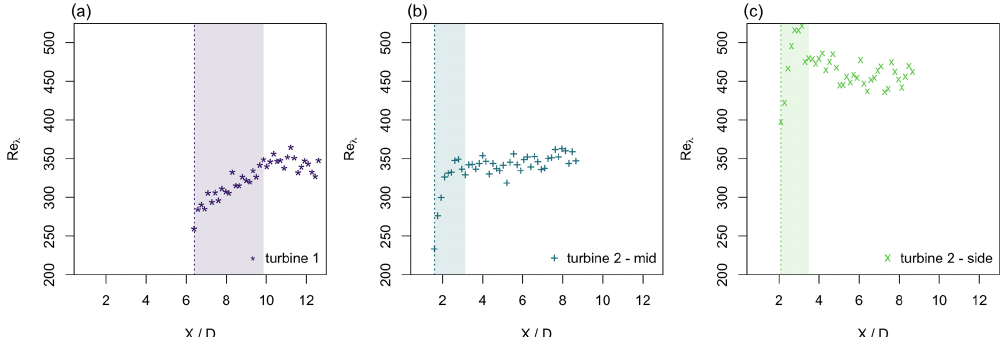
Figure 3. Downstream evolution of the Taylor Reynolds number Re λ for the three different inflow conditions at the centerline in the decay region of the TI: (a) turbine 1 – laminar inflow, (b) turbine 2 mid – turbulent, and (c) turbine 2 side – turbulent and intermittent. The vertical lines mark the maximum of the TI, and the colored area marks the region where the Taylor Reynolds number is